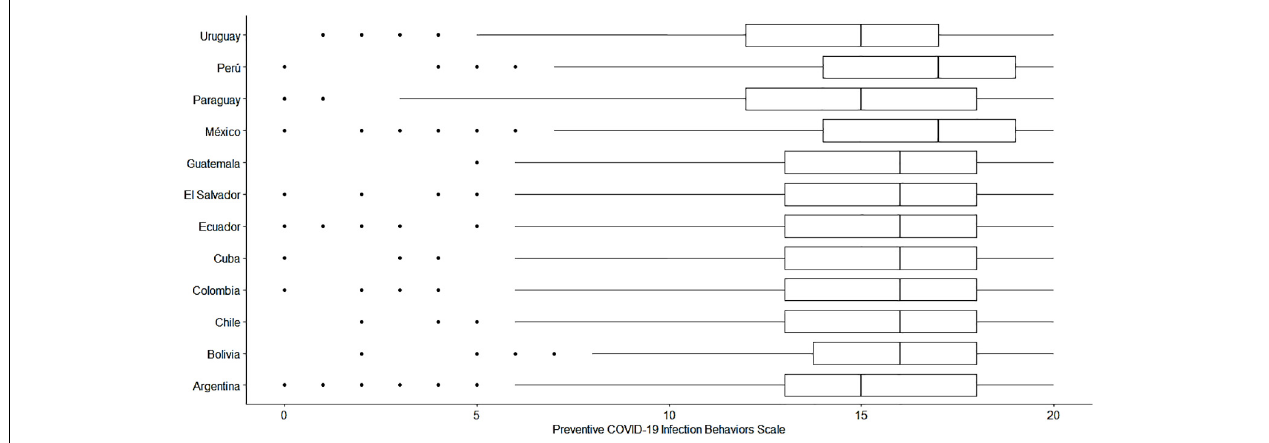
FIGURE 1 | Comparison of the scores of the Preventive COVID-19 Infection Behaviors Scale by country. TABLE 7 | Discrimination and difficulty parameters for the scale items. Model